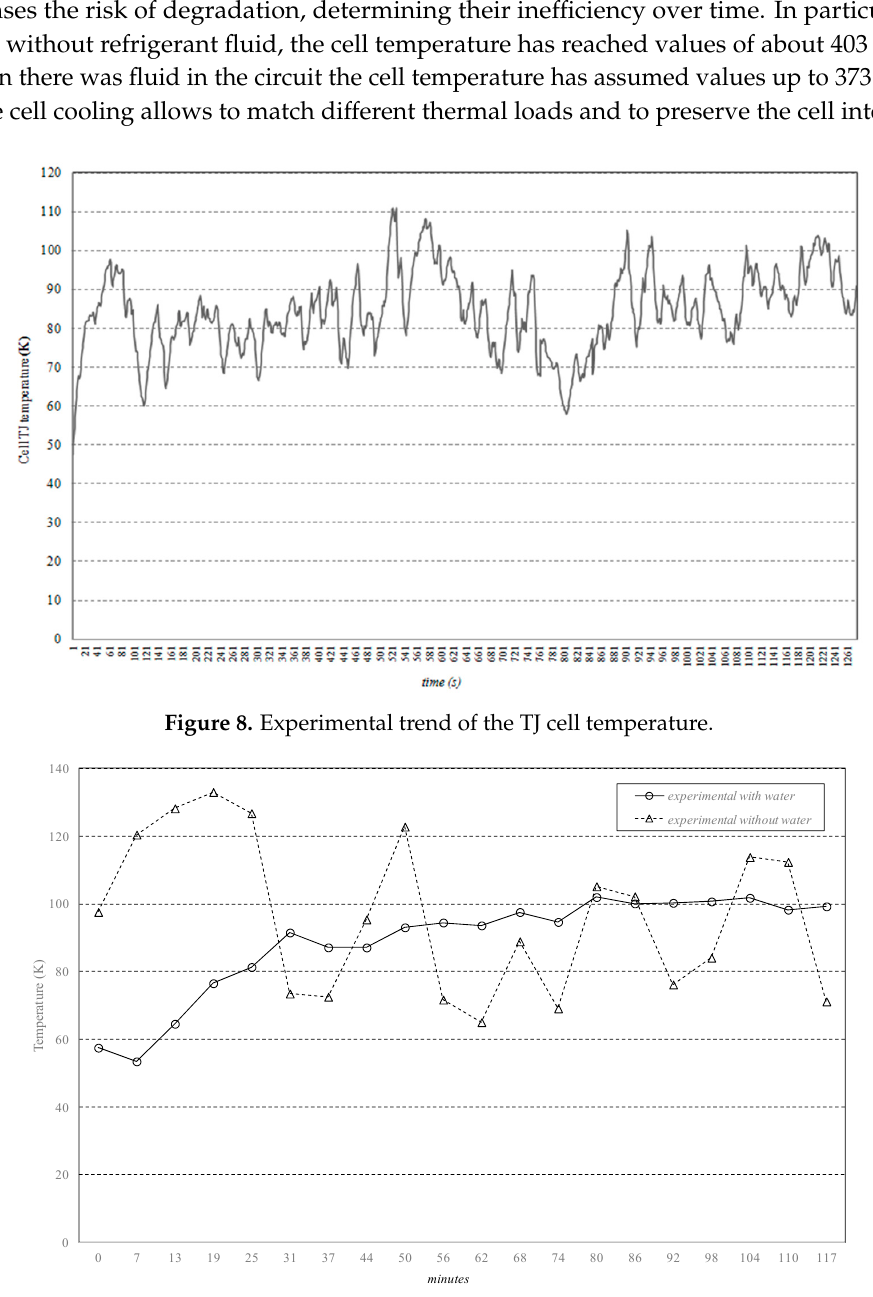
Figure 7. Electrical power of the experimental linear focus CPV/T system.